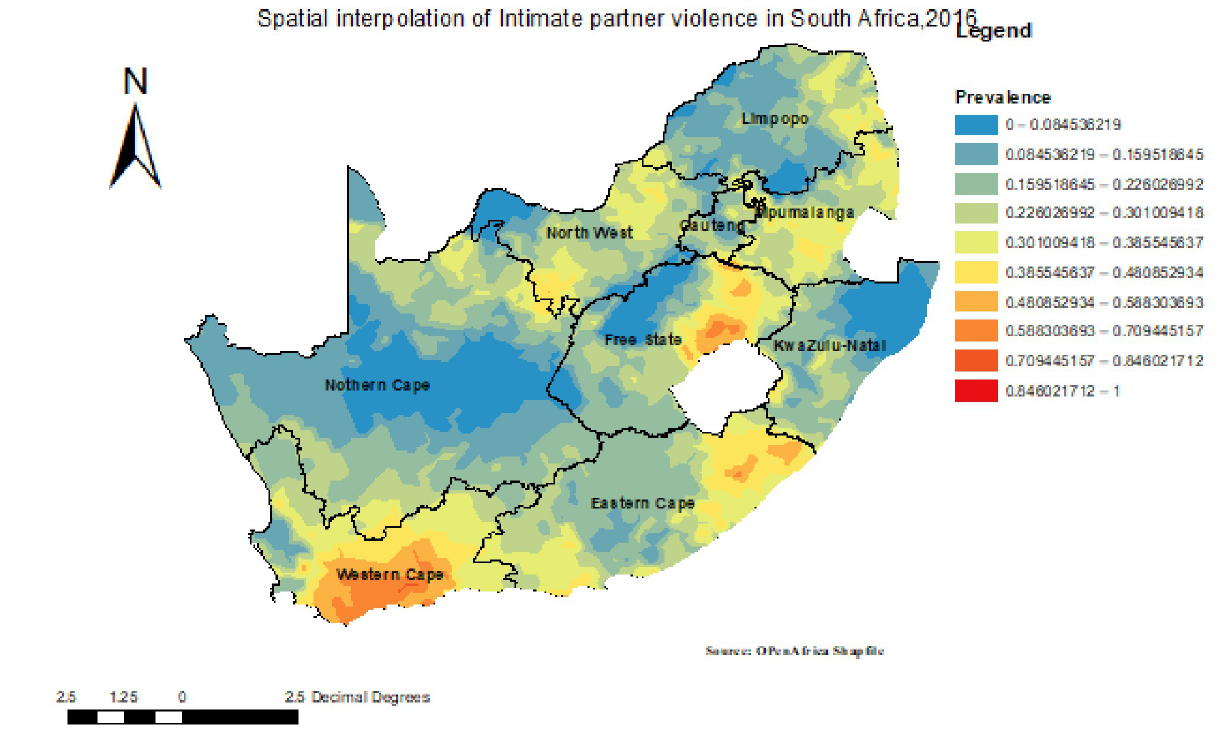
Fig 3. The interpolation of intimate partner violence in South Africa, 2016. Attributions to ESRI.